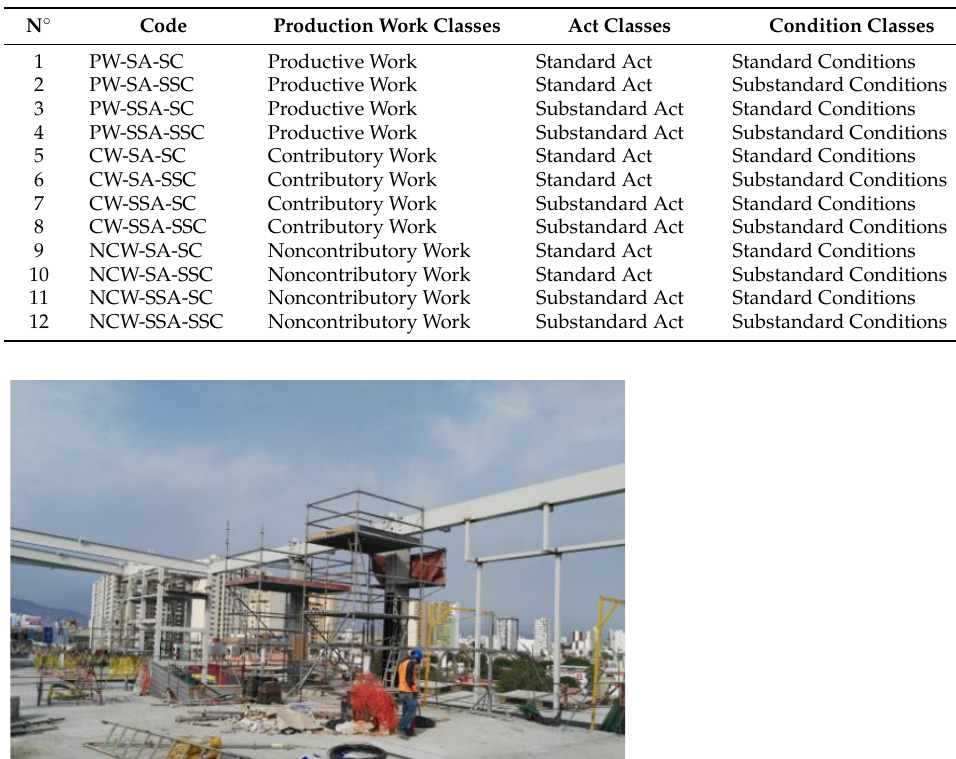
Table 1. Classification of production and safety work [11].